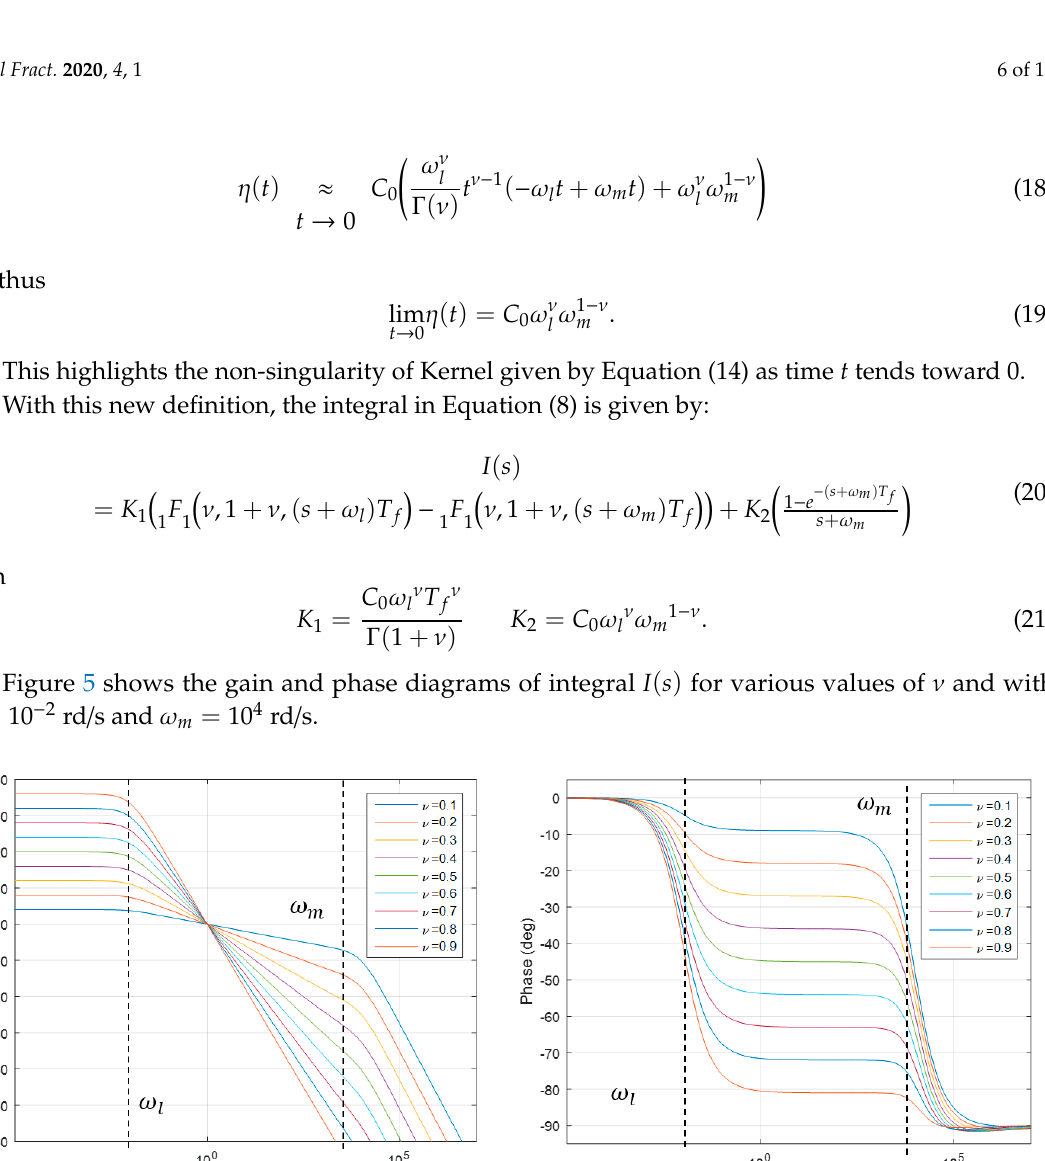
(cid:2879)(cid:2870) rd/s, 𝜔 (cid:2872) rd/s. (cid:3039) = 10 (cid:3040) = 10